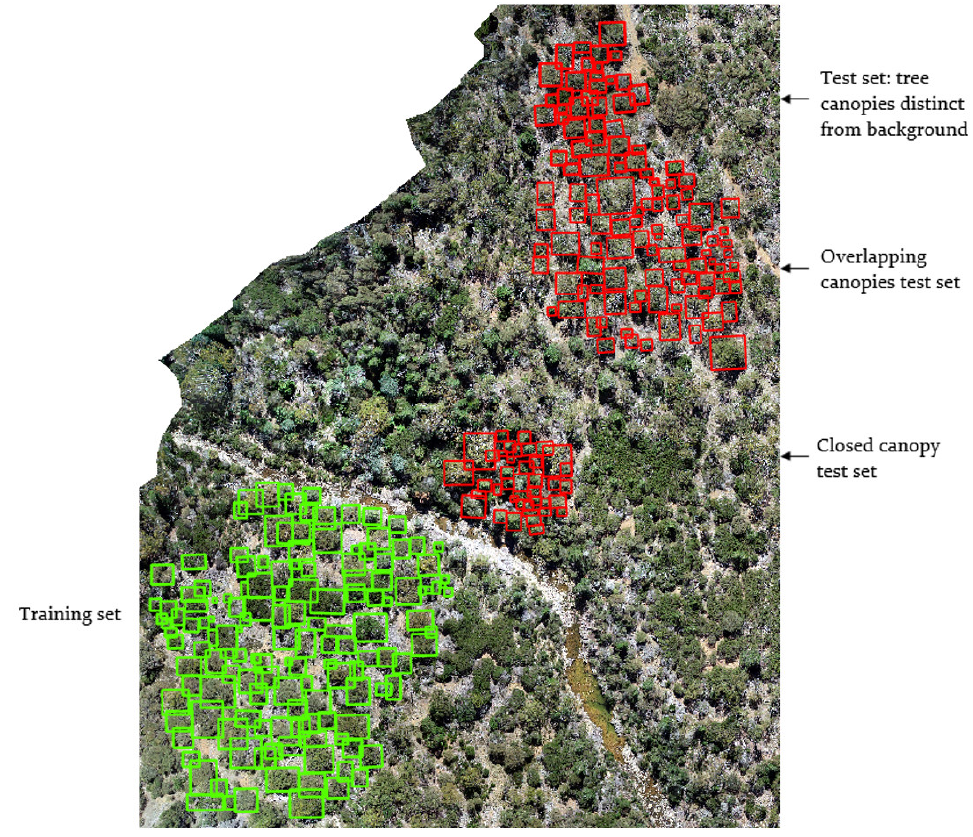
Figure 3. Location of the training (green) and three test (red) datasets. The training and test files were trimmed to include the extent of the bounding boxes.